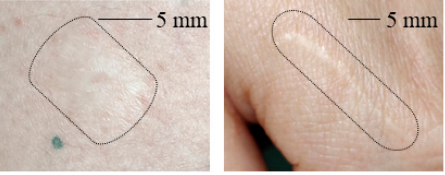
Figure 3. ( Left ): Photo of a contracture scar resulting from a burn. ( Right ): Photo of a hypertrophic Figure 3. Left : Photo of a contracture scar resulting from a burn. Right : Photo of a hypertrophic scar. scar. The scarred area on the skin is marked in each image. The scarred area on the skin is marked in each image.